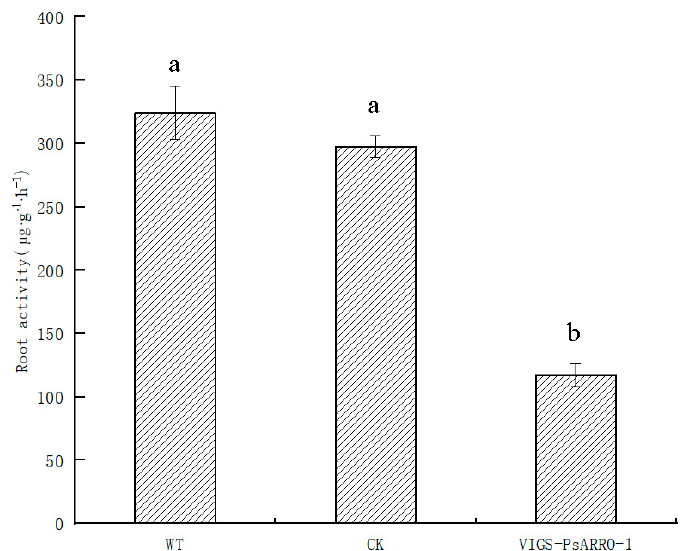
Figure 9. Root activity of different PsARRO − 1 treated transgenic Paeonia suffruticosa seedling. Differ-